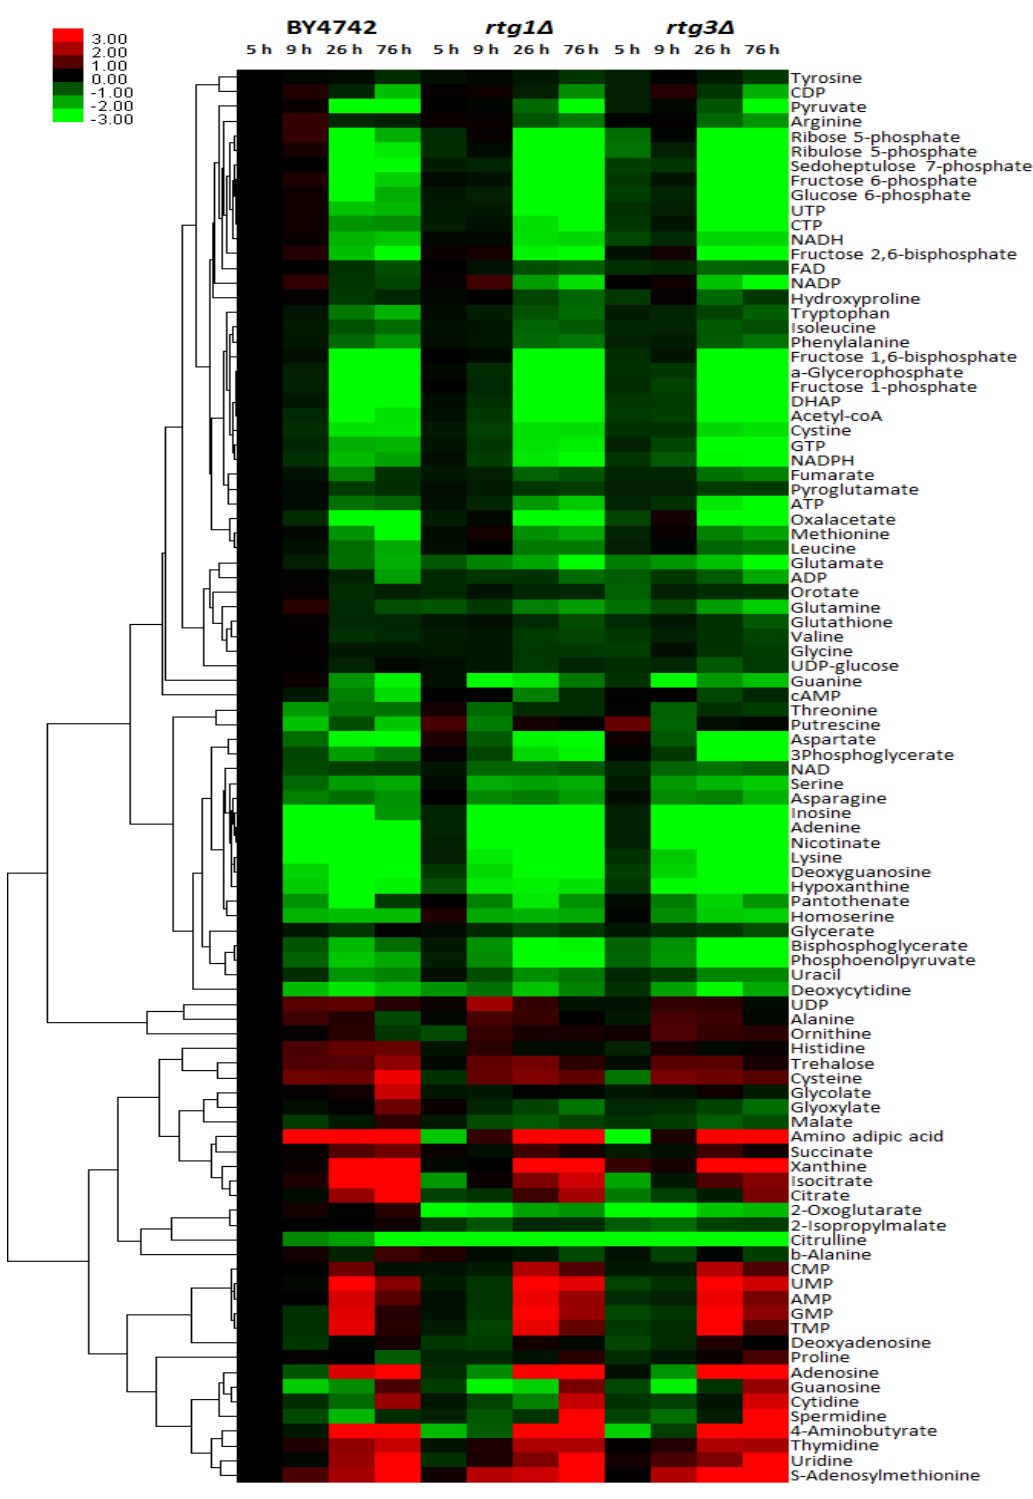
Figure 4. Heat map showing the differential metabolic expression in the BY4742, rtg1 ∆ and rtg3 ∆ strains at four different time points. Metabolite intensities were normalized to an internal standard and relative to those of wild-type BY4742 at time 5 h (OD averaged and log-2 transformed. Metabolite clustering was based on Pearson’s correlation and the average linkage (the distance between two clusters, x and y, is calculated as the average of all pairwise distances between the items contained in x and